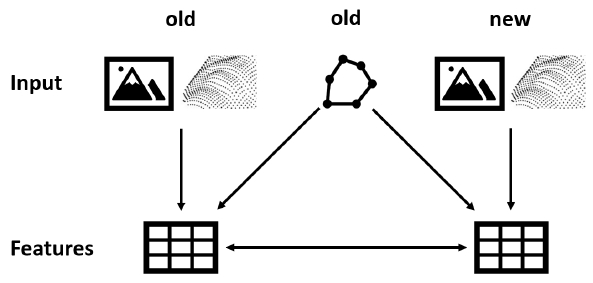
Figure 2. Components used in the feature extraction step